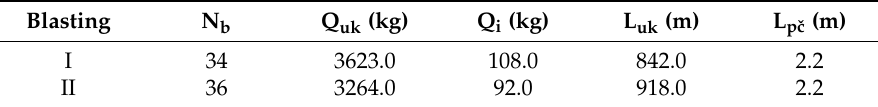
Table 3. Survey of blasting parameters in the Kovilovaˇca Open Pit.